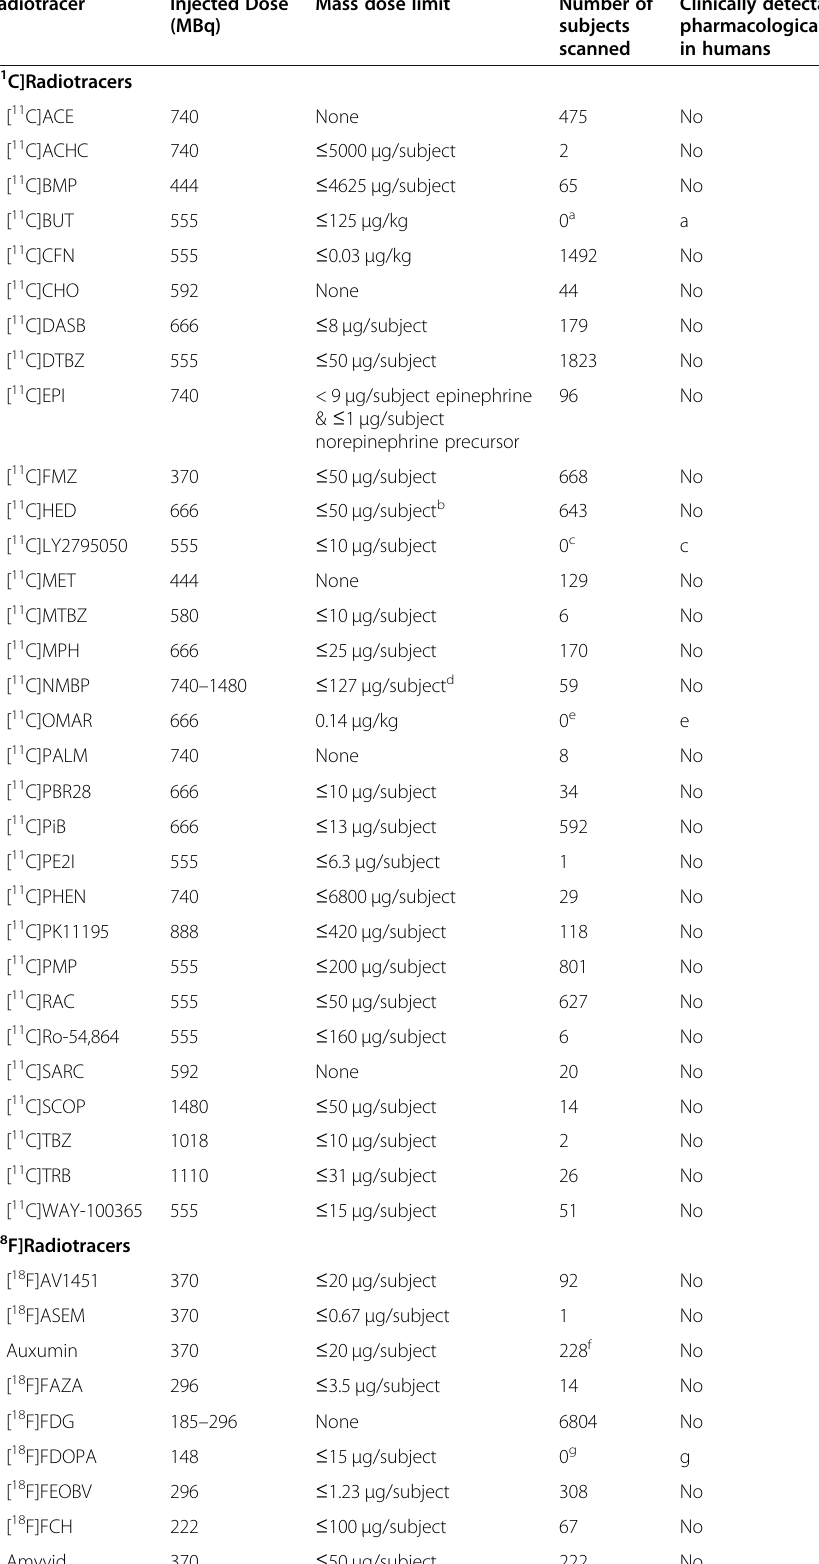
Table 2 Dosing information